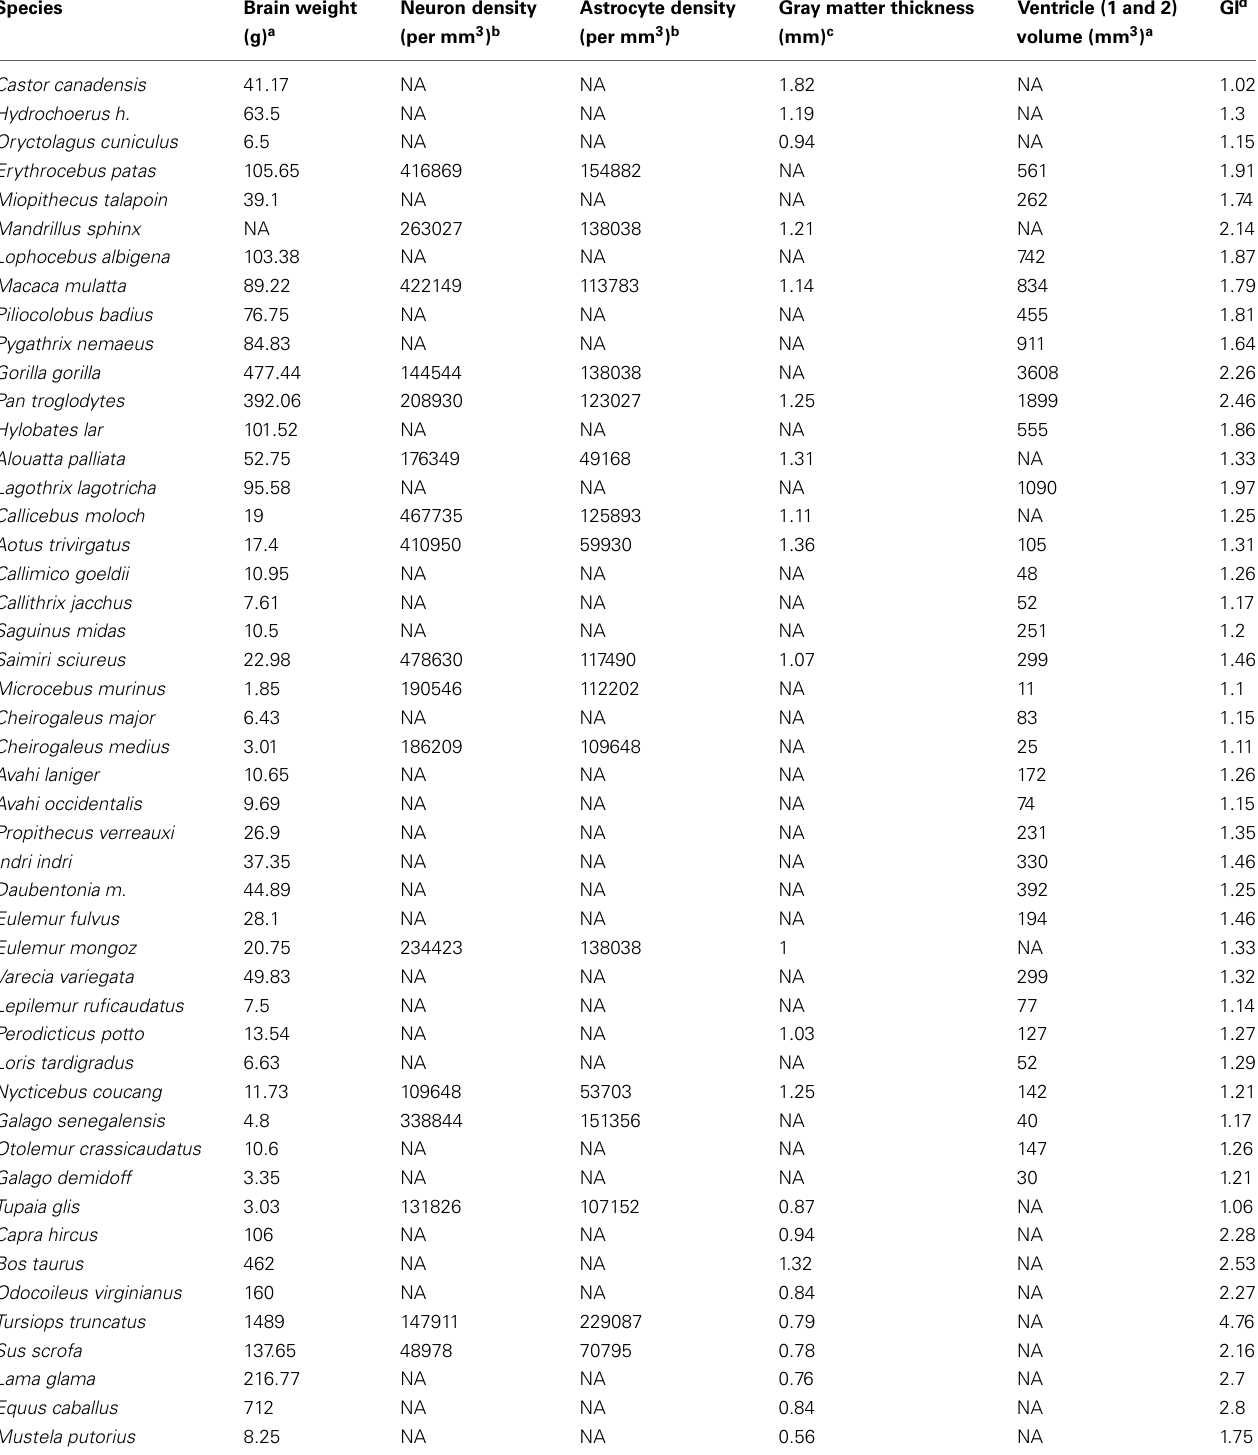
Table A1 | Neuroanatomical parameters in 40 mammal